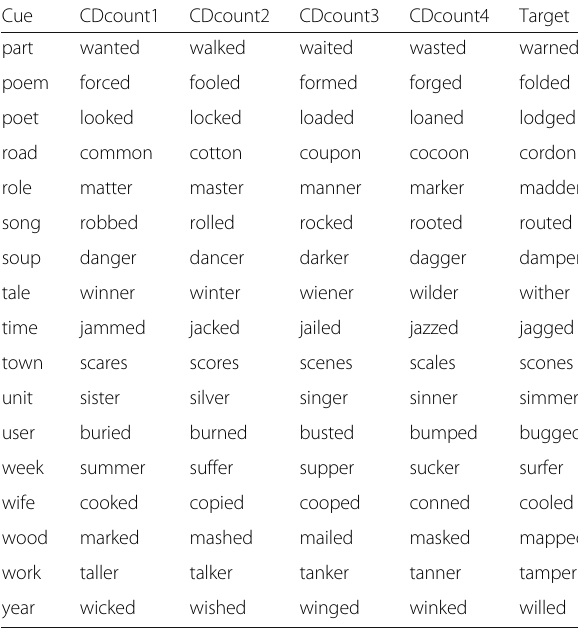
Table 2 Cue-target pairs used in Experiments 1, 2, and 3